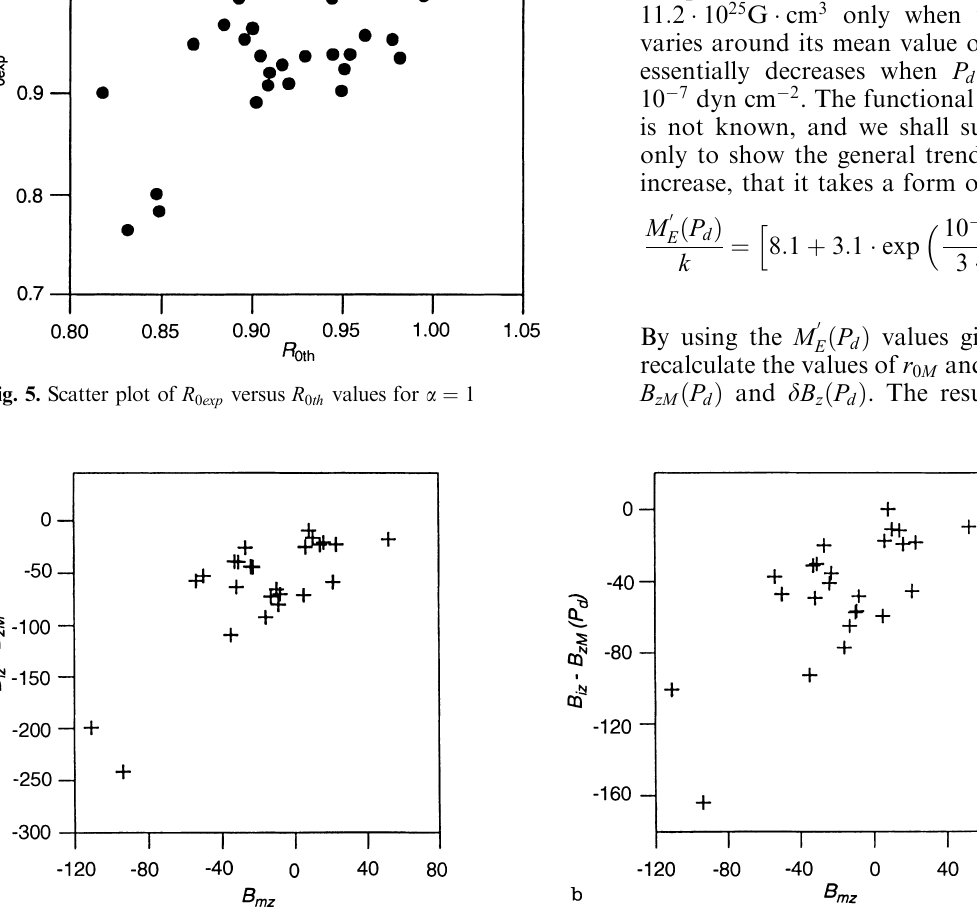
Fig. 6a, b. Scatter plots of (cid:100) B z versus B mz values. a (cid:100) B z (cid:136) B iz (cid:255) B zM . b (cid:100) B z (cid:136) B iz (cid:255) B zM (cid:133) P d